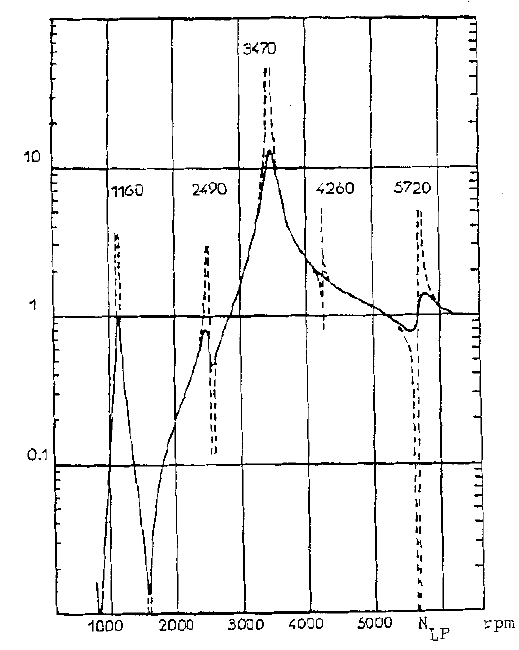
Fig. 11. Mass unbalance